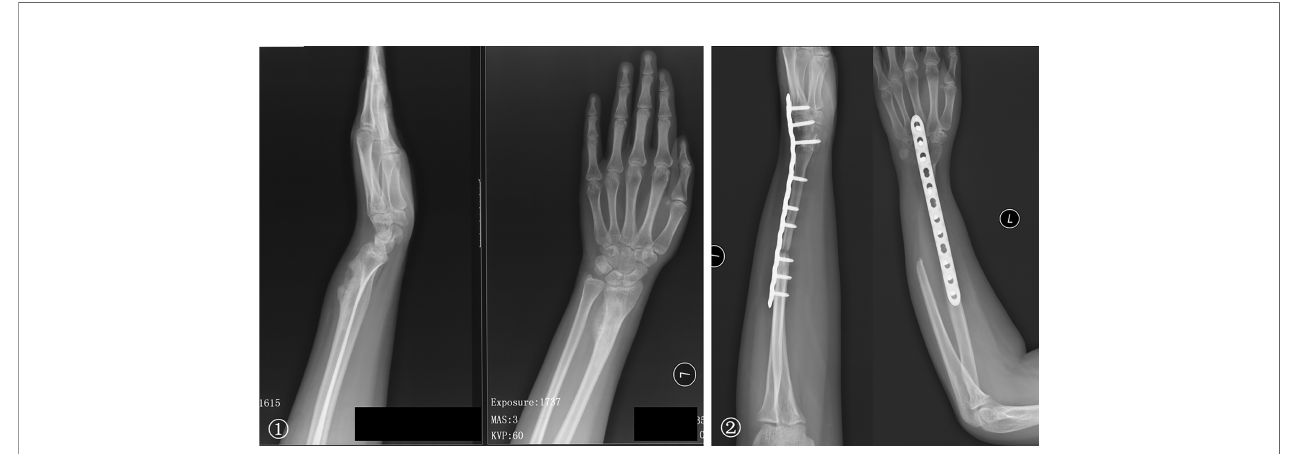
FIGURE 6 | ① The preoperative radiographs of a 19-year-old woman with low-grade central osteosarcoma of the distal radius. ② Treatments included a distal radius resection; ipsilateral ulnar osteotomy to replace the radial defect. Wrist joint fusion was performed; the satisfactory bone healing of the forearm and rotation function is shown 50 months